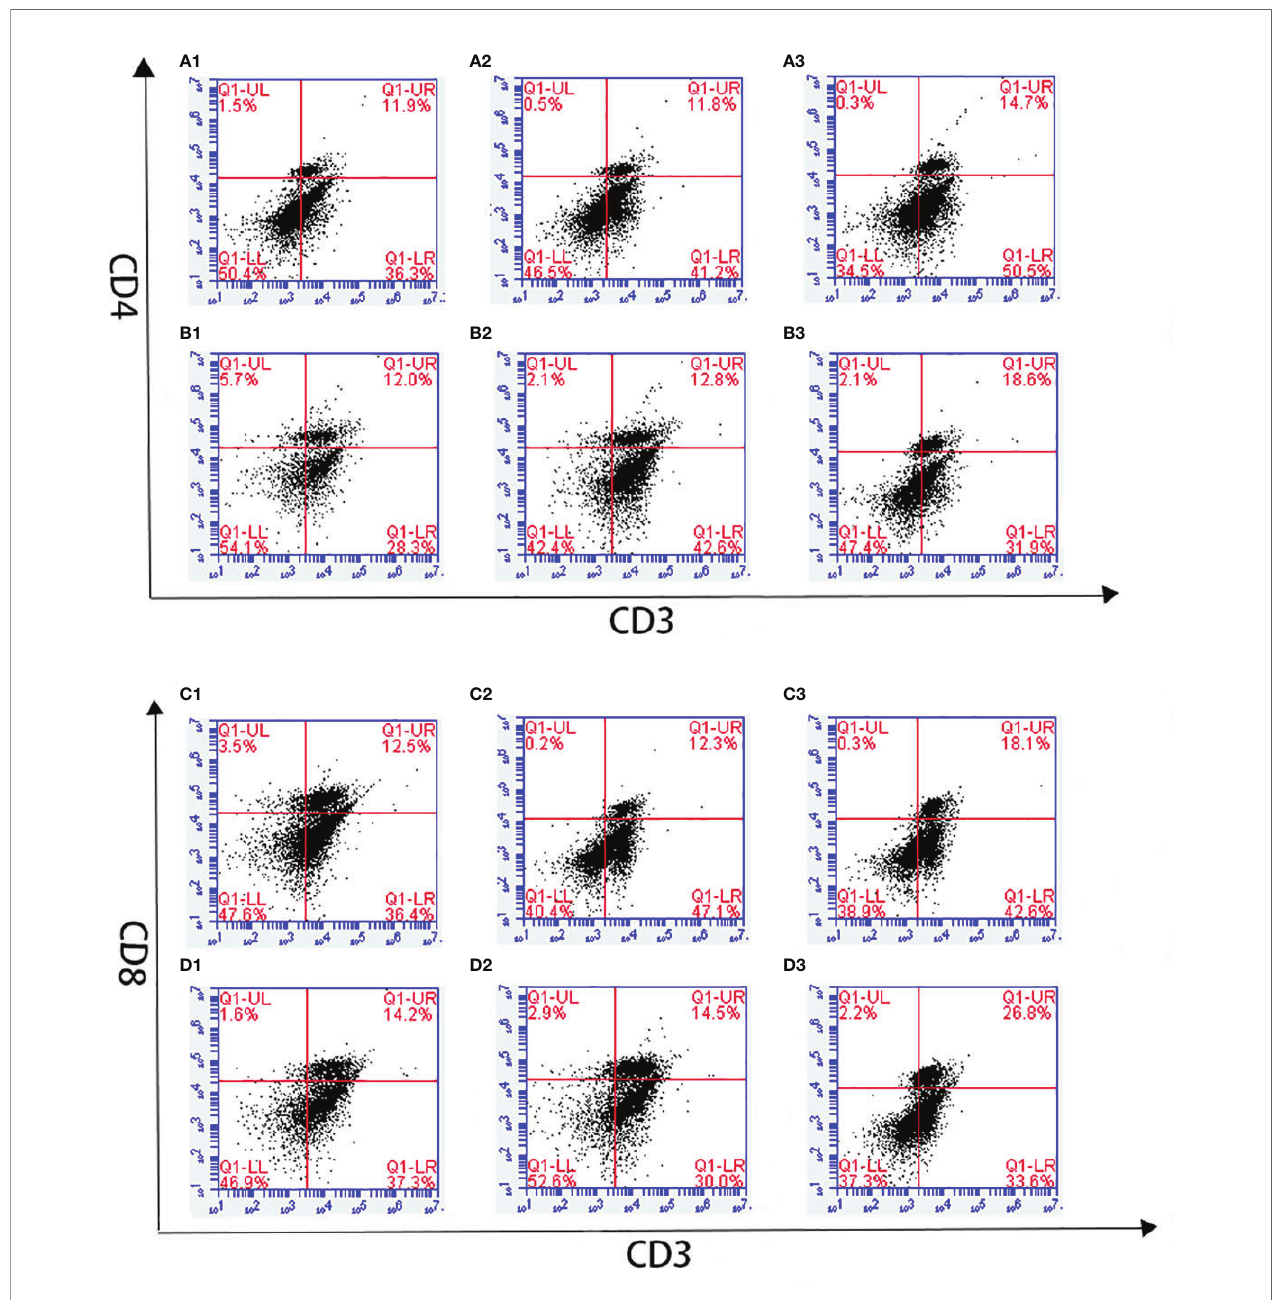
FIGURE 7 | The proportion of T lymphocyte subsets in spleen of pVAX1-EmARM- b immunized chickens. (A) Determination of CD4 + /CD3 + T lymphocyte in immunized chicken spleen at 21 days old. (B) Determination of CD4 + /CD3 + T lymphocyte in immunized chicken spleen at 28 days old. (C) Determination of CD8 + / CD3 + T lymphocyte in immunized chicken spleen at 21 days old. (D) Determination of CD8 + /CD3 + T lymphocyte in immunized chicken spleen at 28 days old. 1: PBS (negative control). 2: The ratio of T lymphocytes in chicken spleen immunized with plasmid pVAX1. 3: The ratio of T lymphocytes in spleens from chickens immunized with recombinant plasmid pVAX1-EmARM- b